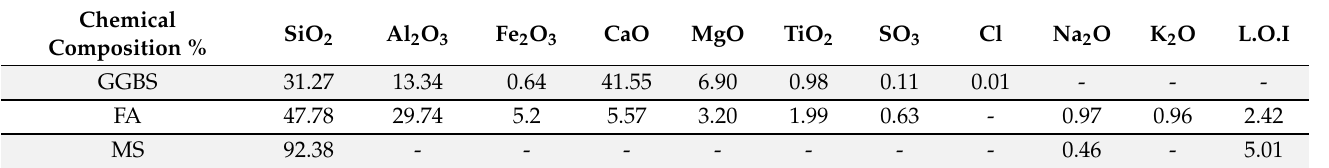
Table 3. Chemical composition for cementitious materials.